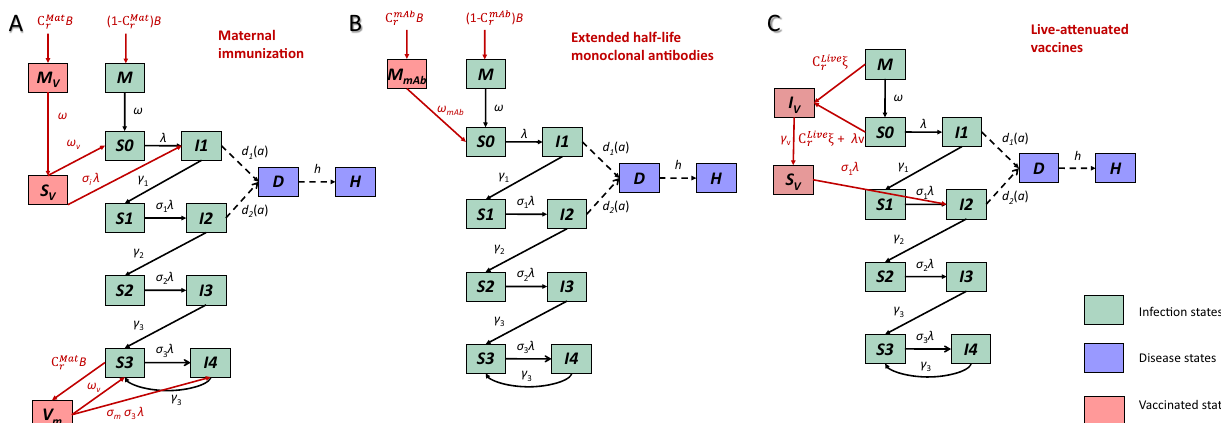
Fig. 3 Transmission model structure and immunization strategies. A the maternal immunization strategy, B extended half-life monoclonal antibodies, and C live-attenuated vaccines. The green compartments represent RSV transmission dynamics. Compartments M stand for infants who are protected by maternally derived immunity. Compartments S stand for susceptible status. The subscripts of S compartments represent the number of previous infections. Compartments I stand for the infected and infectious status. The subscripts of I compartments indicate whether current infection is the fi rst, second, third or subsequent infections. The purple compartments are the observational-level disease states, where D stands for lower respiratory tract diseases and H stands for hospitalized. The pink compartments are immunized states. In panel A , M v represents infants who are born to vaccinated mothers and are fully protected by maternally derived immunity. After the transplacentally acquired immunity wanes, infants who are born to vaccinated mothers become susceptible ( S v ) to RSV infection with a reduced risk. V m represents the vaccinated mothers. In panel B , M mAb represents infants who receive long-lasting mAbs at birth. In panel C , I v represents the newly vaccinated infants who can shed vaccine viruses. After the acute vaccine-shedding period, vaccinated infants gain partial immunity and become less susceptible to RSV infection ( S v ), comparable to the S 1